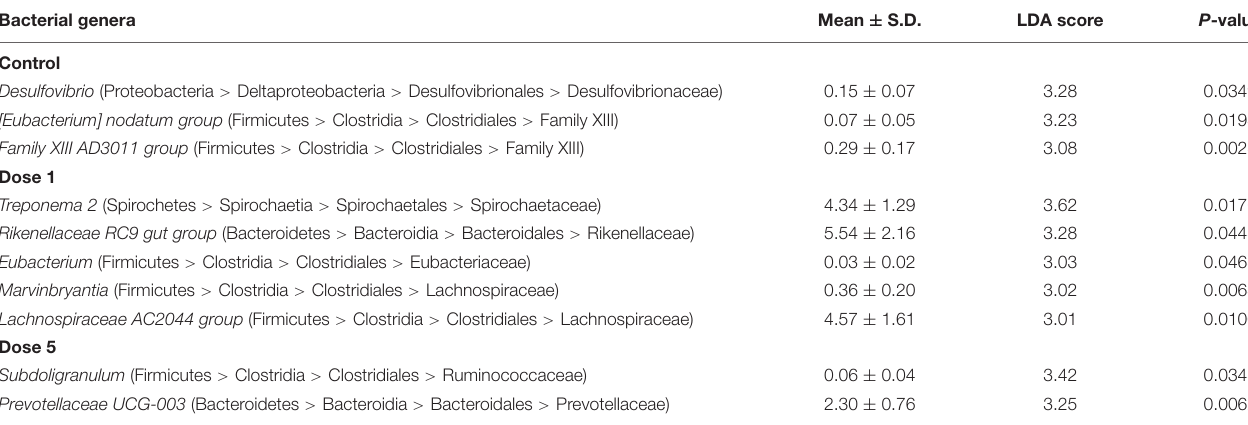
TABLE 2 | LDA scores and mean relative abundance of the discriminant bacterial genera enriched in the fecal microbiota of horses under different supplementation modalities. Bacterial genera Mean ±